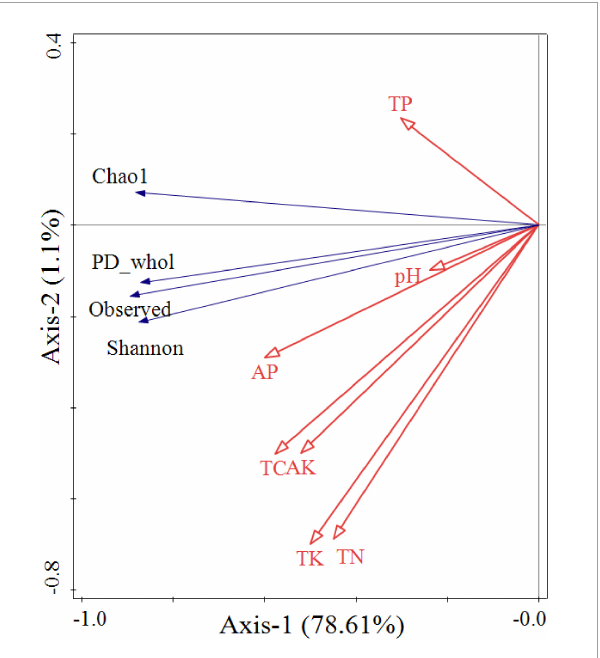
FIGURE4 Redundancy analysis of bacterial diversity and soil chemical properties. The TP, TC, TN, TK, AK, and AP stand for total P, total C, total N, total K, available K and available P, respectively.